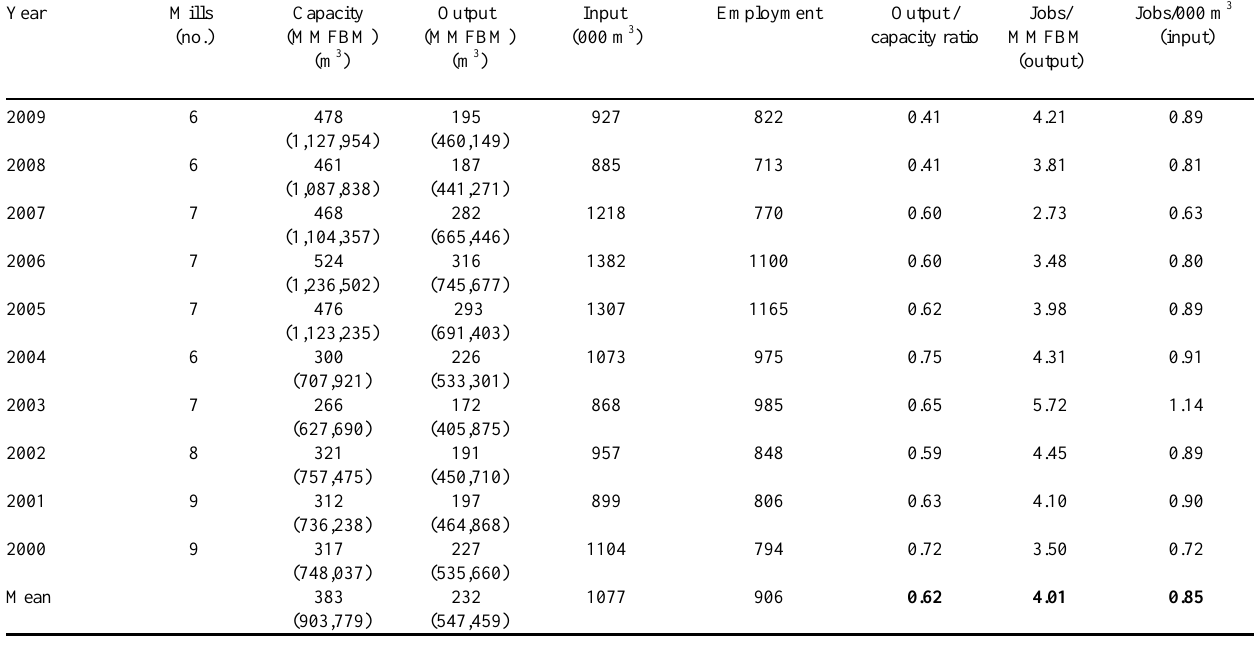
Table 3 . Output/capacity ratio and jobs per unit of input and output for specialty mills, 2000 to 2009 ( personal communication , Sinclair Tedder, senior economist, Competitiveness and Innovation Branch, British Columbia Ministry of Forests and